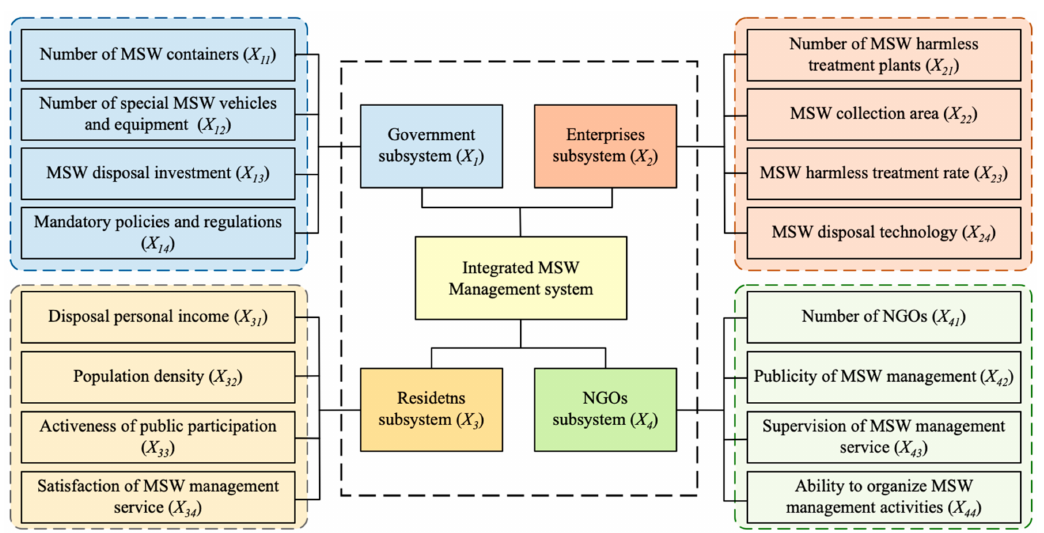
Figure 1. Study area.